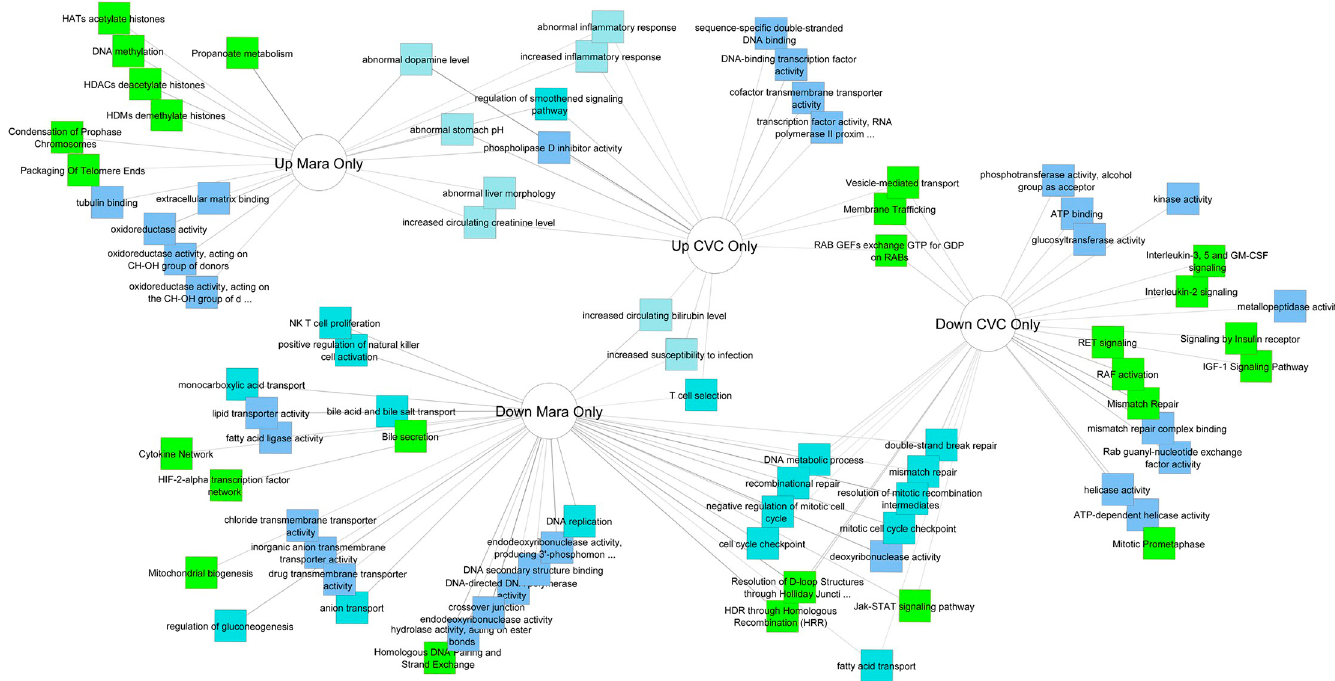
Fig 5. RNAseq analysis. Huh7.5 JFH1 cells were exposed to sofosbuvir, cenicriviroc, maraviroc, or raltegravir for 24 hours. Cenicriviroc and maraviroc triplicate samples from day 1 post-drug incubation were compared to day 1 samples treated with sofosbuvir, with significance defined as p < 0.05 and fold-change > 1.5. Day 1 sofosbuvir-treated versus untreated samples were compared, and those genes from the cenicriviroc versus sofosbuvir and maraviroc versus sofosbuvir gene sets were removed to identify genes specific to the experimental treatments rather than the antiviral activity of sofosbuvir. Cenicriviroc and maraviroc-specific gene sets were submitted to Toppcluster (toppcluster.cchcm.org) and cytoscape for ontological analysis and network generation.